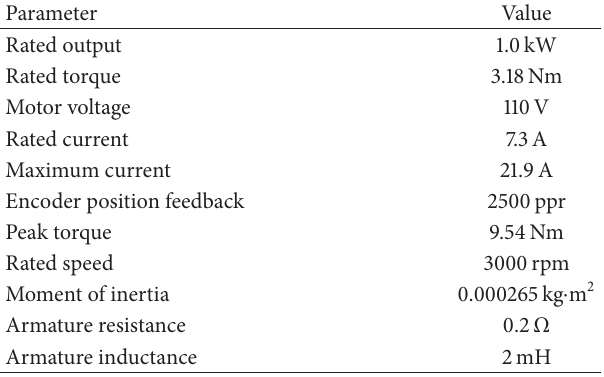
Table 2: Technical specifications of three-phase PMSM.